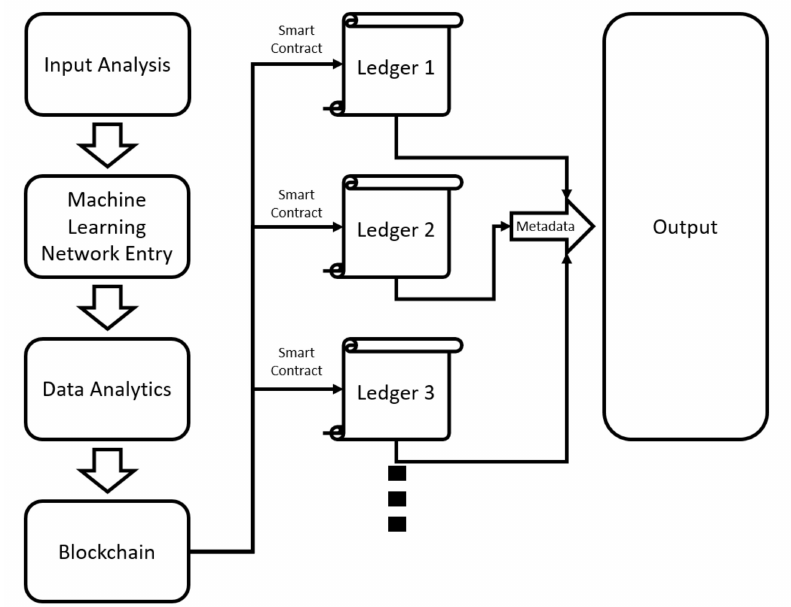
Figure 6. Machine learning and blockchain integration